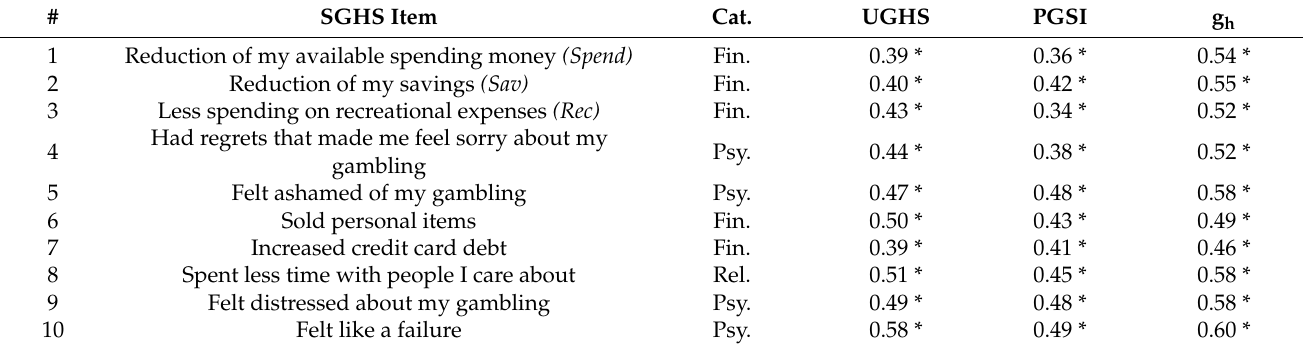
Table 4. Evaluation of individual SGHS items with respect to three benchmarks. Suspect items shaded